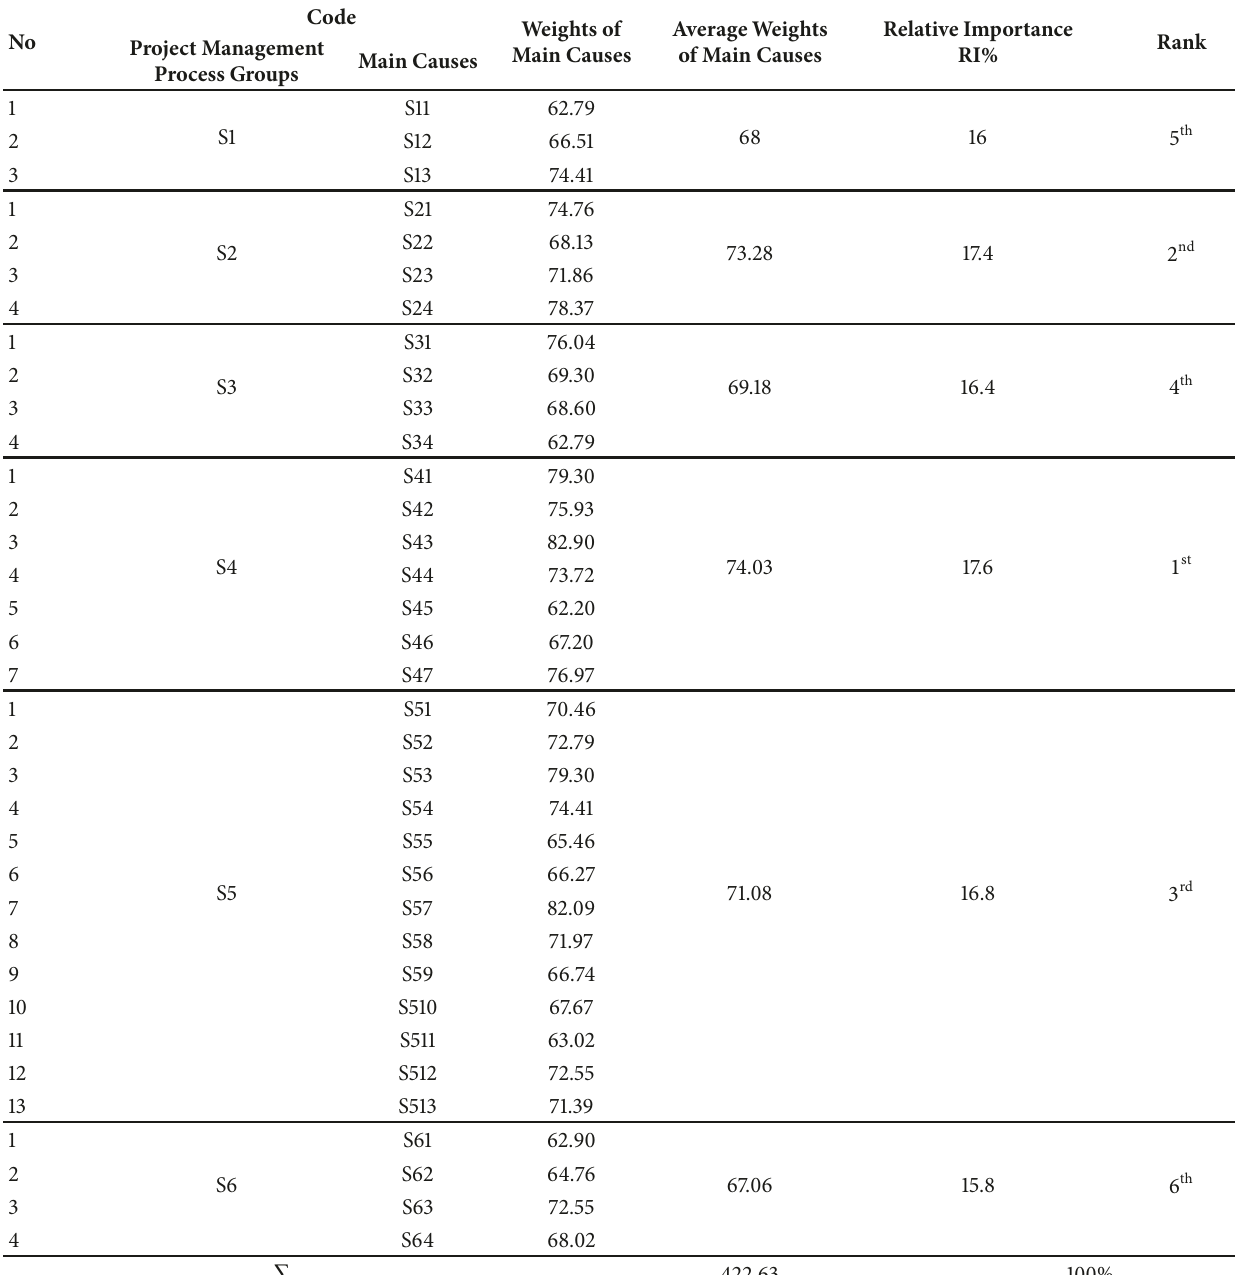
Table 3: Main causes weight, relative importance, and